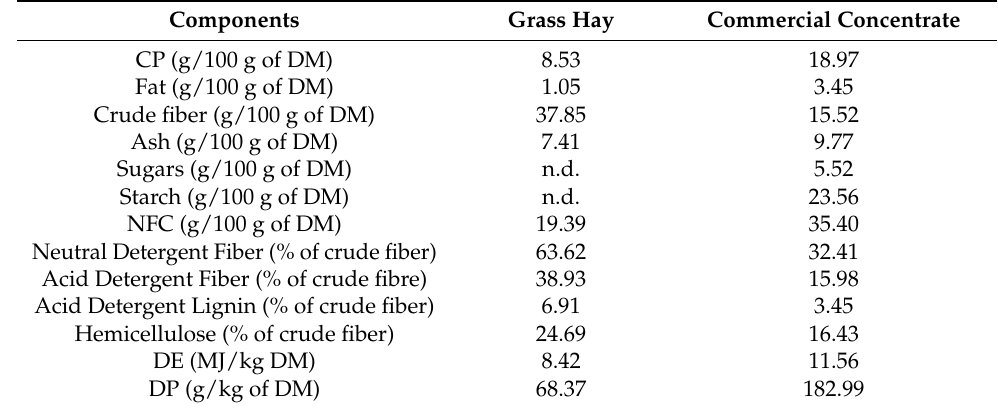
Table 1. Chemical composition and nutritive value of hay and concentrate for the donkeys’ diet. All components are expressed on a dry matter